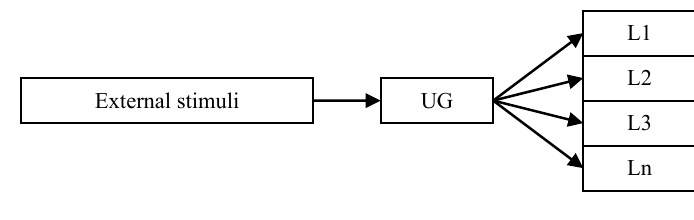
Figure 1: The role of Universal Grammar in standard